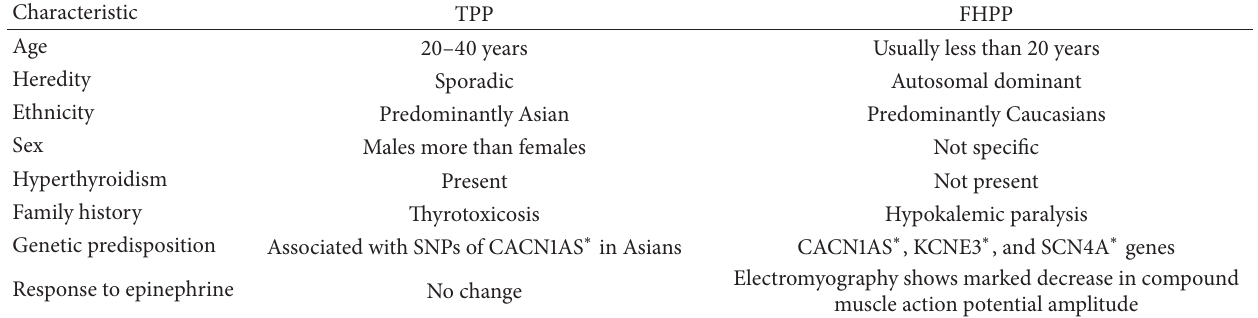
Table 1: Differences between thyrotoxic periodic paralysis (TPP) and familial hypokalemic periodic paralysis